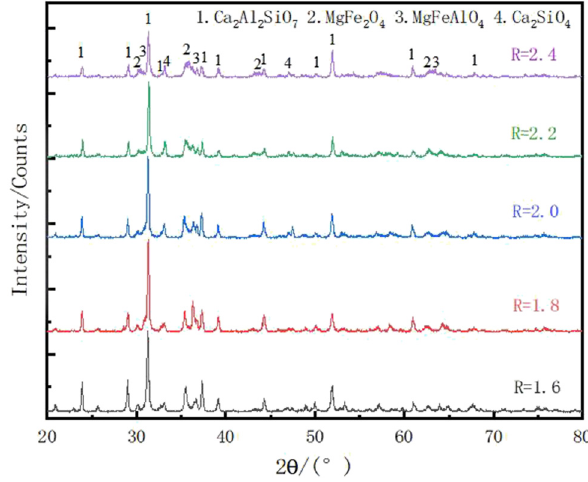
Figure 3: XRD Patterns of mixed slag with di ff